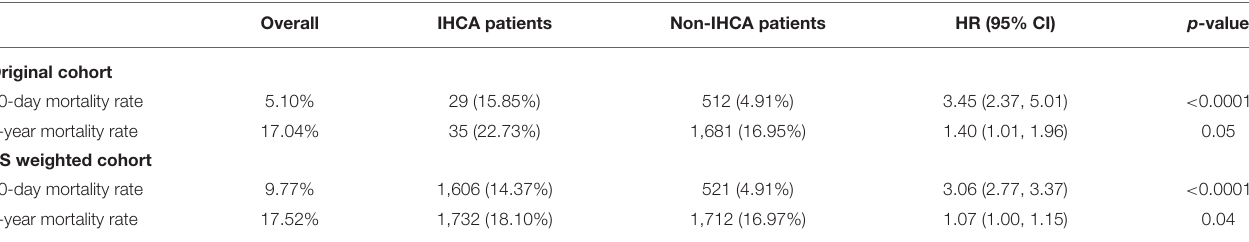
TABLE 3 | Comparison of post-discharge 30-day or 1 year survival between patients with and without IHCA during hospitalization. Overall